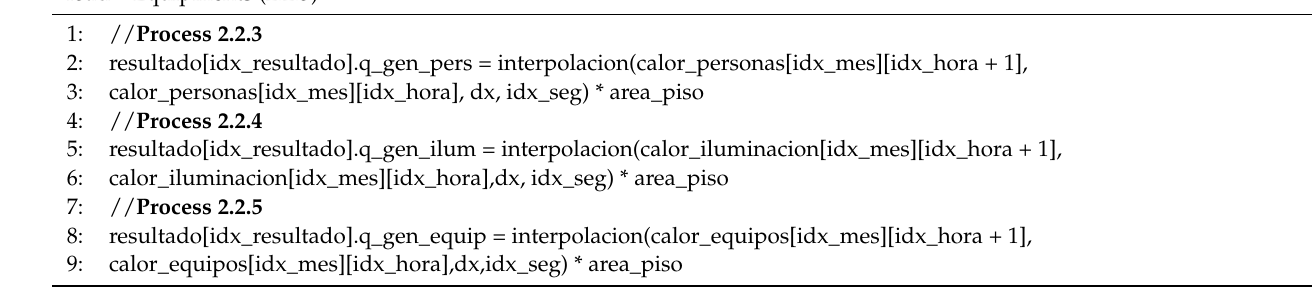
Algorithm 2. Compute Internal load—Ocuppants (2.2.3), Compute Internal load—Lights (2.2.4) and Compute Internal load—Equipments (2.2.5)